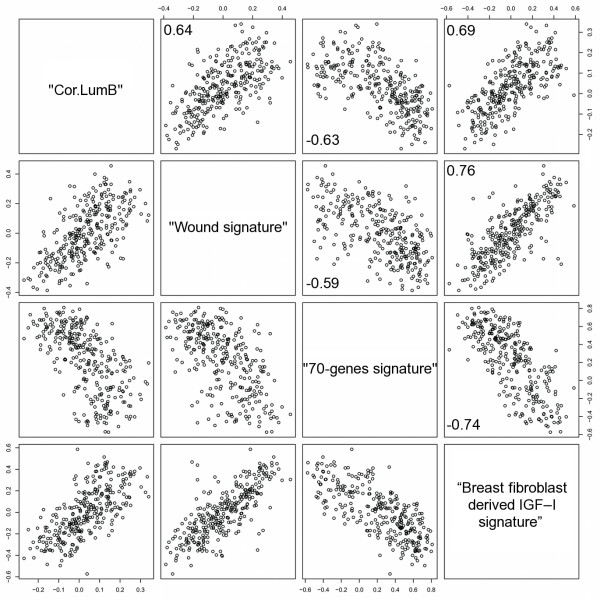
Correlation of the breast fibroblast derived insulin-like growth factor-I (IGF-I) signature with previously reported prognosticators in breast cancer. Correlation of the good-risk 70-genes signature centroid [49], the wound signature centroid [60], the basal type of breast cancer created by Soerlie [46] and the breast fibroblast IGF-I induced signature score in the Netherlands Cancer Institute dataset. Pairwise scatterplot-matrix of four gene signatures. Pearson correlations for the signature are shown in the corners of the plots.